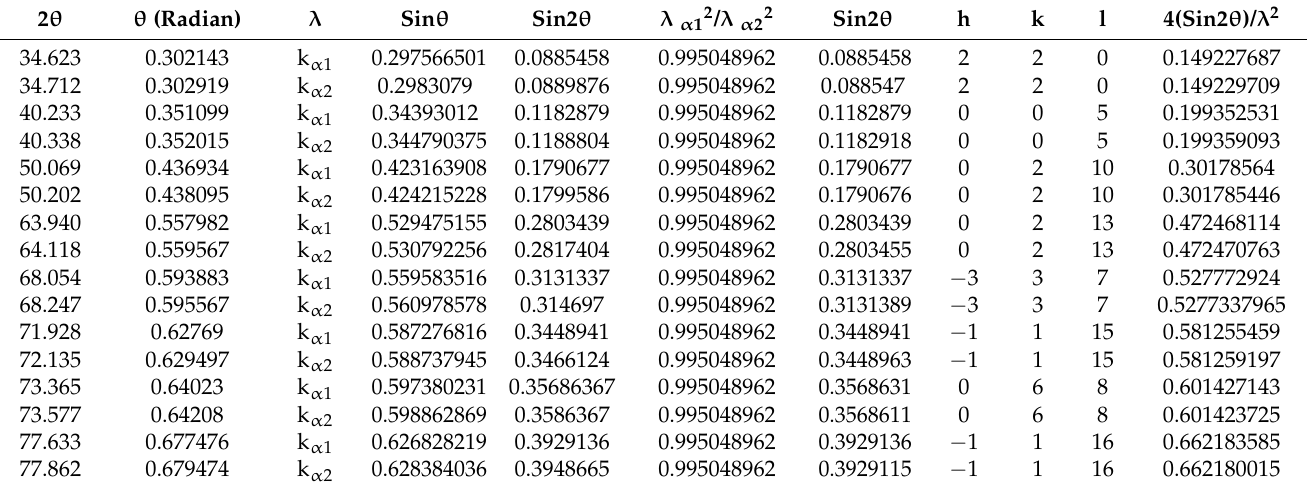
Table A5. Calculations of the d-spacing based on the Braggs equation for the